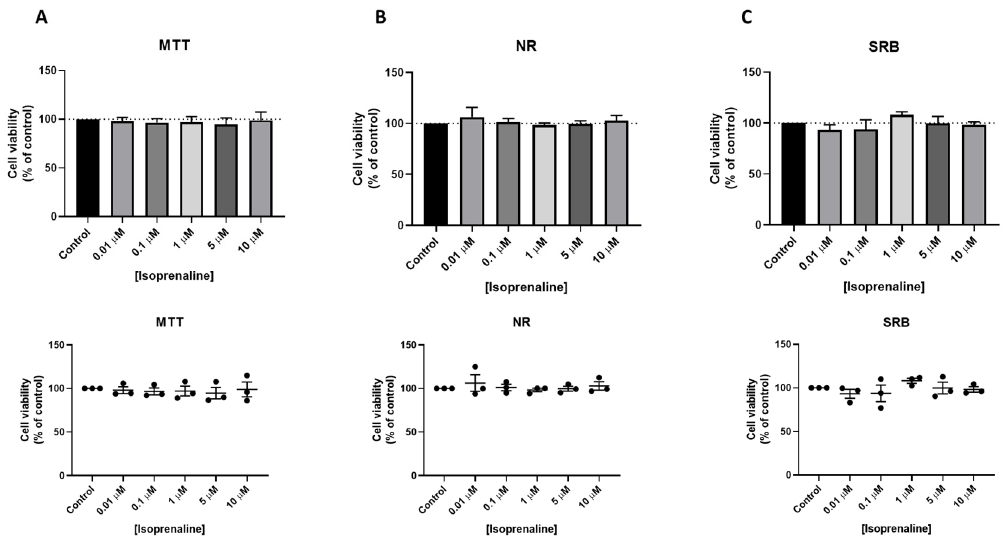
Figure 7. Effects of isoprenaline on the viability of MCF-7 cells determined by ( A ) MTT, ( B ) NR, and ( C ) SRB assays. Cells were treated with increasing concentrations of isoprenaline for 24 h. The results are shown as the percentage of control and are expressed as the mean ± SD of three independent experiments.